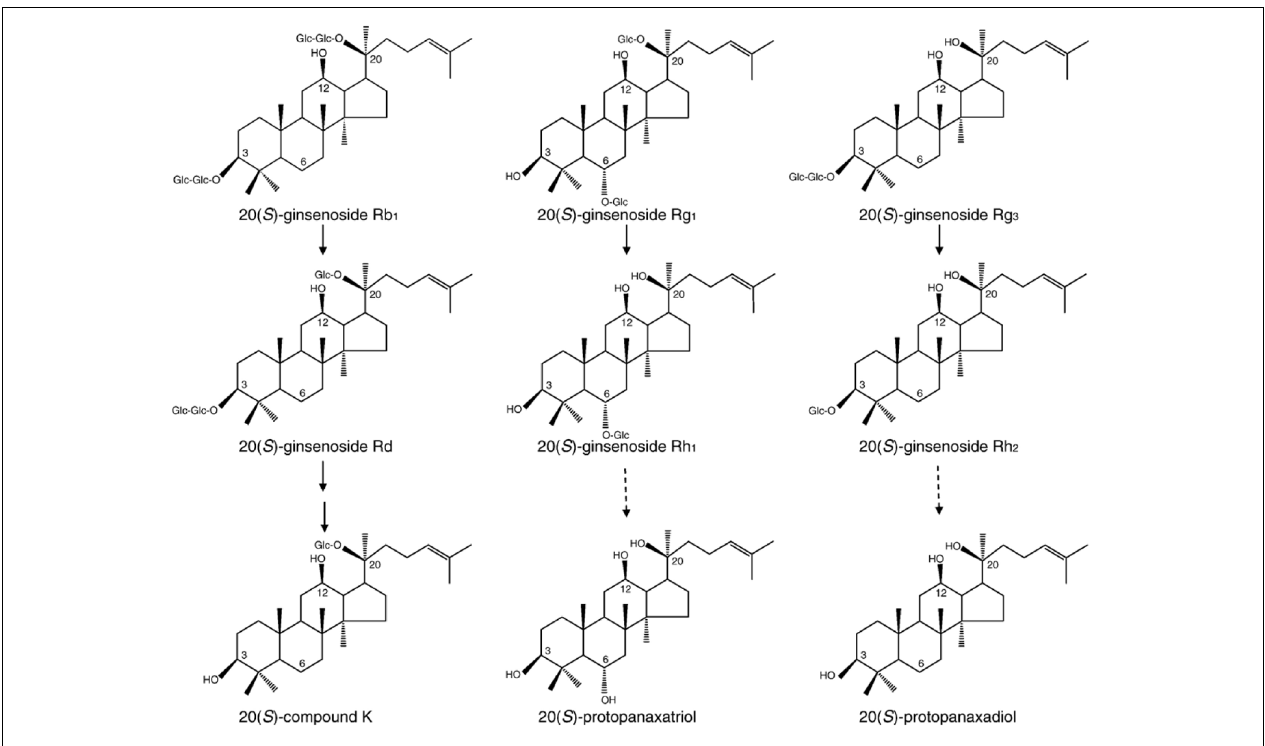
FIGURE 1 | Structures and main metabolic pathways of 20( S )-ginsenoside Rb1, 20( S )- ginsenoside Rg1, and 20( S )- ginsenoside Rg 3 . Ginsenosides are known to be metabolized by human intestinal microflora. This scheme represents the structures